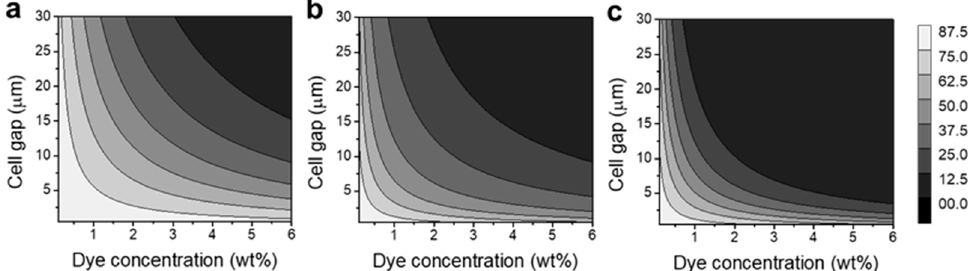
Figure 2. The constant-transmittance contour maps of LC cells in the ( a ) homeotropic, ( b ) homogeneous, and ( c ) twisted states on the parameter space of the dye concentration and cell gap.